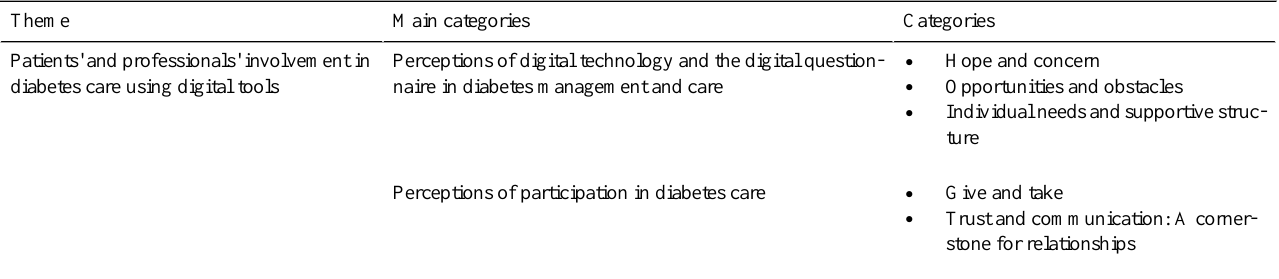
Table 2. Theme, main categories, and